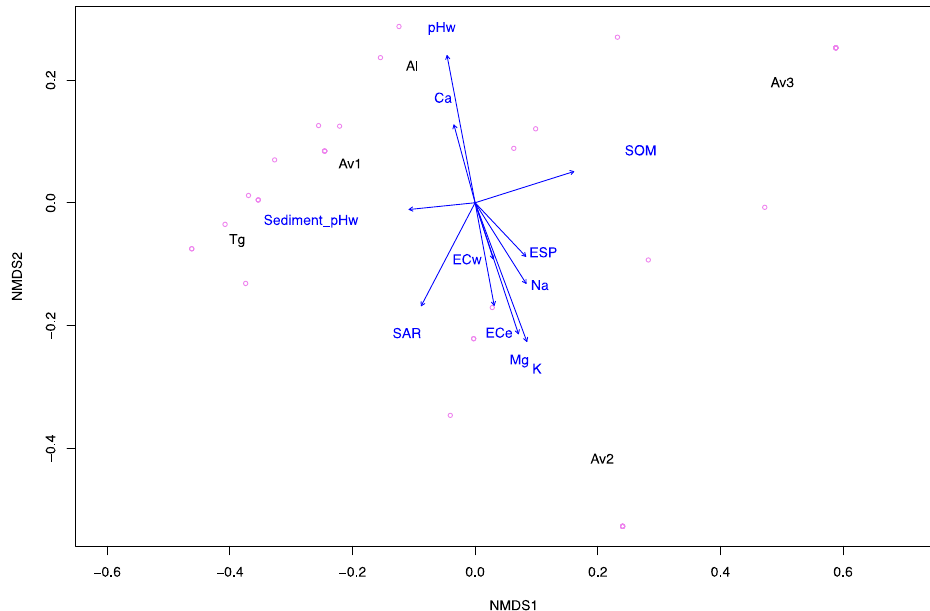
Figure 3. Non-metric multidimensional scaling (NMDS) plot of OTU abundances (violet points) among sampled sites, onto which the sediment parameters Table 1 have been mapped. ECe: electrical conductivity of the sediment saturation extract; ECw: electrical conductivity of pore water; Sediment pHw: pH of sediment determined in water suspensions; SOM: sediment organic matter content.